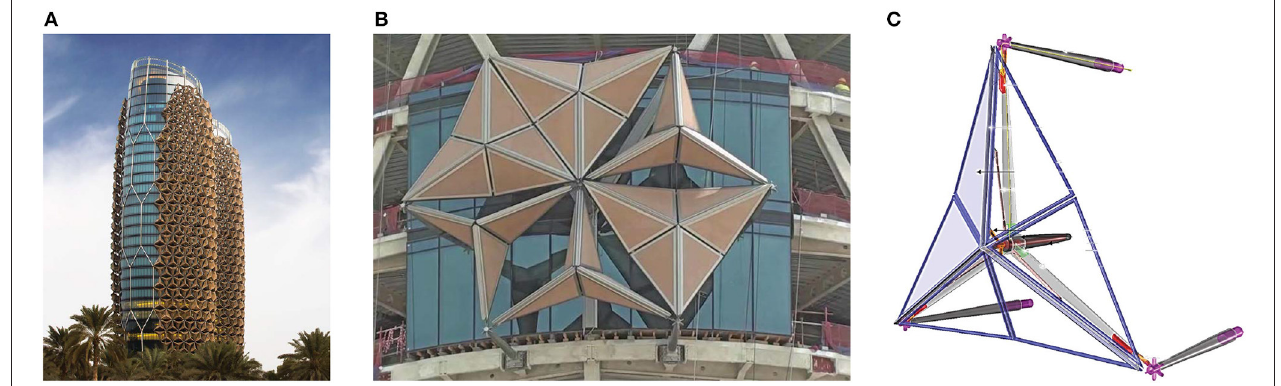
FIGURE 1 | (A) Illustration of the Al Bahar towers in Abu Dhabi. (B) detail of a module of the ABS (picture taken during the mounting of the screens). (C) ABS actuation mechanism (reproduced with permission from Karanouh and Kerber,